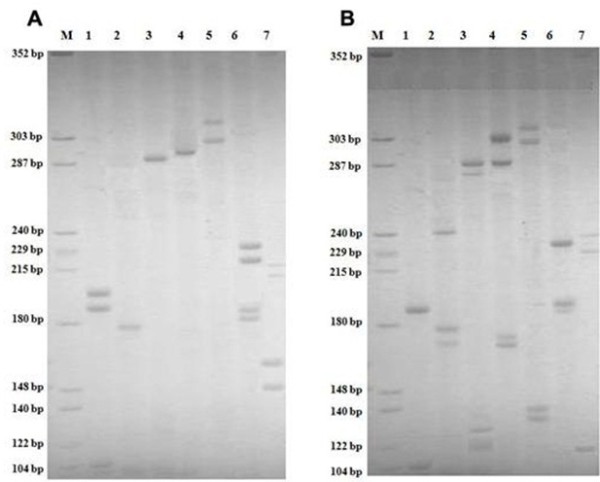
Polyacrylamide Gel Electrophoresis of 13 CODIS STR Loci and Amelogenin for the MBC1 (Panel A) and MBC2 (Panel B) Cell Lines. (Panel A): M: DNA molecular size marker. Lanes 1:[Amelogenin (106 bp), FGA (185 bp, 193 bp)], 2:[D8S1179 (165 bp)], 3:[D16S539 (290 bp)], 4:[D18S51 (292 bp)], 5:[CSF1PO (304 bp, 324 bp)], 6:[TH01 (181 bp, 185 bp), TPOX (225 bp, 236 bp)], and 7:[VWA (145 bp, 150 bp), D21S11 (213 bp, 218 bp)]. (Panel B): M: DNA molecular size marker. Lanes 1:[Amelogenin(106 bp), FGA(190 bp)], 2:[D8S1179 (171 bp, 179 bp), D7S820 (239 bp)], 3:[D3S1358 (122 bp, 124 bp), D16S539 (284 bp, 291 bp)], 4:[D13S317 (169 bp, 173 bp), D18S51(289 bp, 304 bp)], 5:[D5S818 (133 bp, 139 bp), CSF1PO (302 bp, 310 bp)], 6:[TH01 (189 bp, 193 bp), TPOX (232 bp], and 7:[VWA (122 bp), D21S11 (228 bp, 240 bp)].